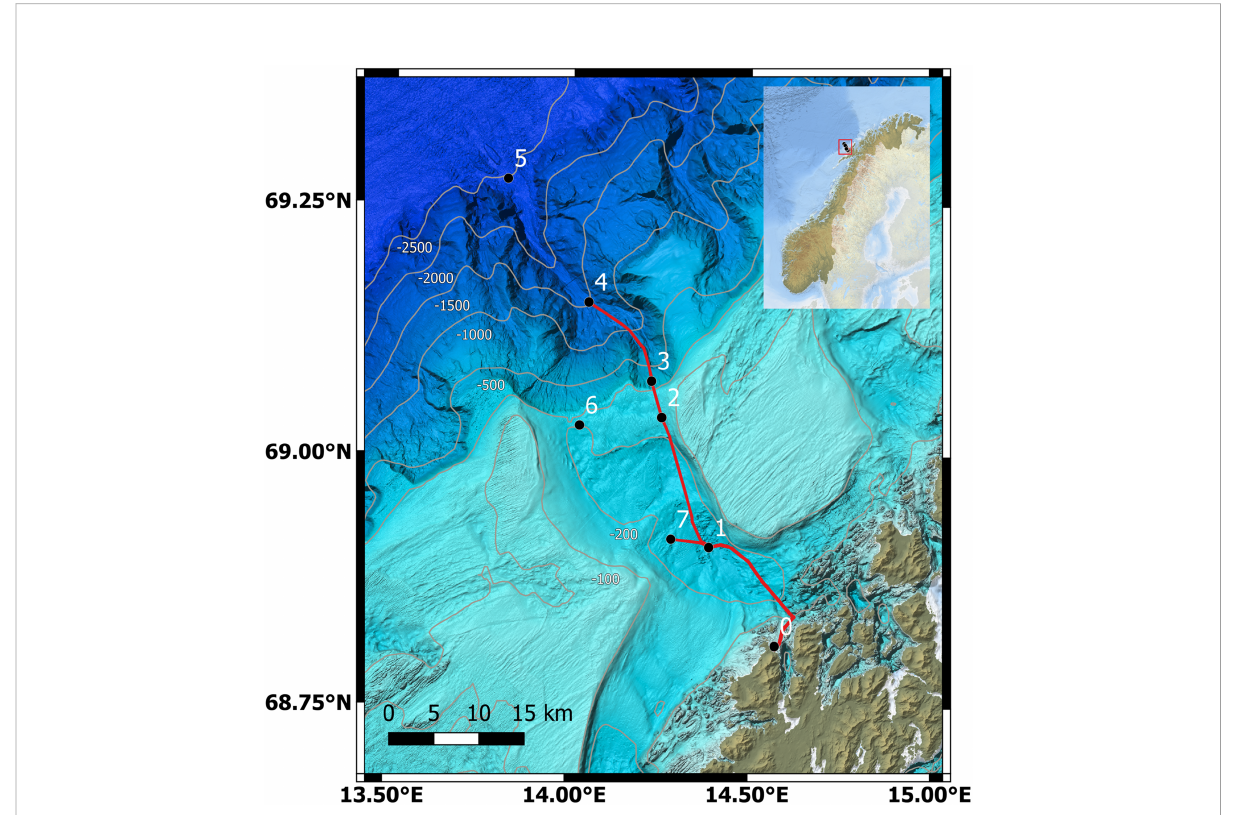
FIGURE 1 Map of the sampling-nodes of the LoVe Ocean Observatory, Norway. Data used in this study were collected by Node 1 (Equinor and IMR, 2020). Produced by Geir Pedersen and reprinted with permission from Tyarks et al., 2021 (Copyright 2021, Frontiers in Marine